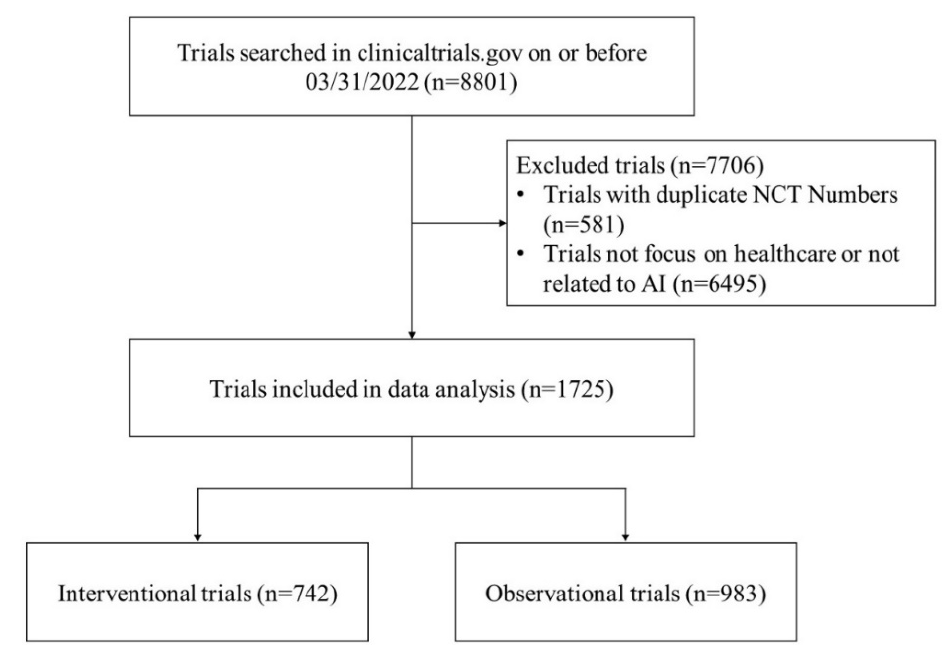
Figure 1. Flowchart of trial selection.